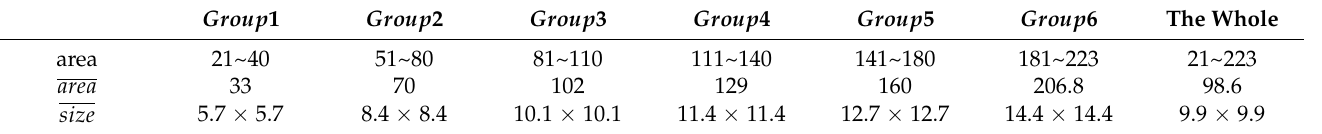
Table 3. The details of defects in magnetic tile images. The area of a defect is the number of its pixels. Group 1 Group 2 Group 3 Group 4 Group 5 Group 6 The Whole